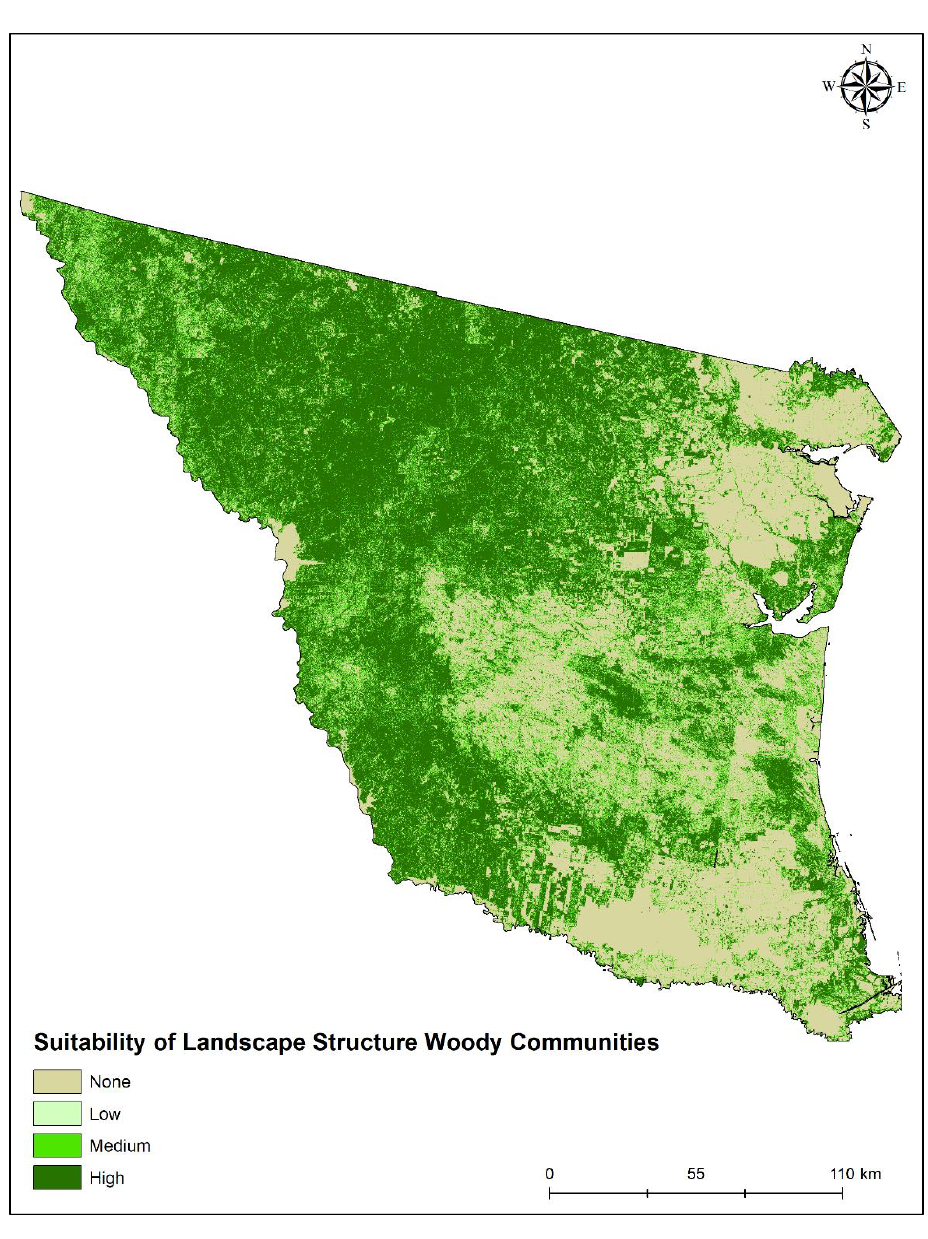
Figure 2. Suitability map of landscape woody cover structure (high (6–7 metrics), medium (3–5 metrics), low (1–2 metrics) none (0 metrics)) for ocelots in southern Texas. Percentage of combined ocelot locations in high suitability cover was 84.8% (observed in this study from 2016 to 2020). We observed variation in the percentage of historical ocelot relocations in high suitable cover (2013: 90.9%, 2014: 64.4%, and 2015: 87.9%). Percentage of ocelot relocations observed in this study in medium and low suitable cover was 6.92% and 4.10% (2016–2020), respectively. Model verification indicated percentages of expected ocelot relocations and observed historical ocelot relocations were not statistically different between 2013–2015, except for 2014 ( χ 2 = 38.6, α = 0.05; df = 3; Table 3).